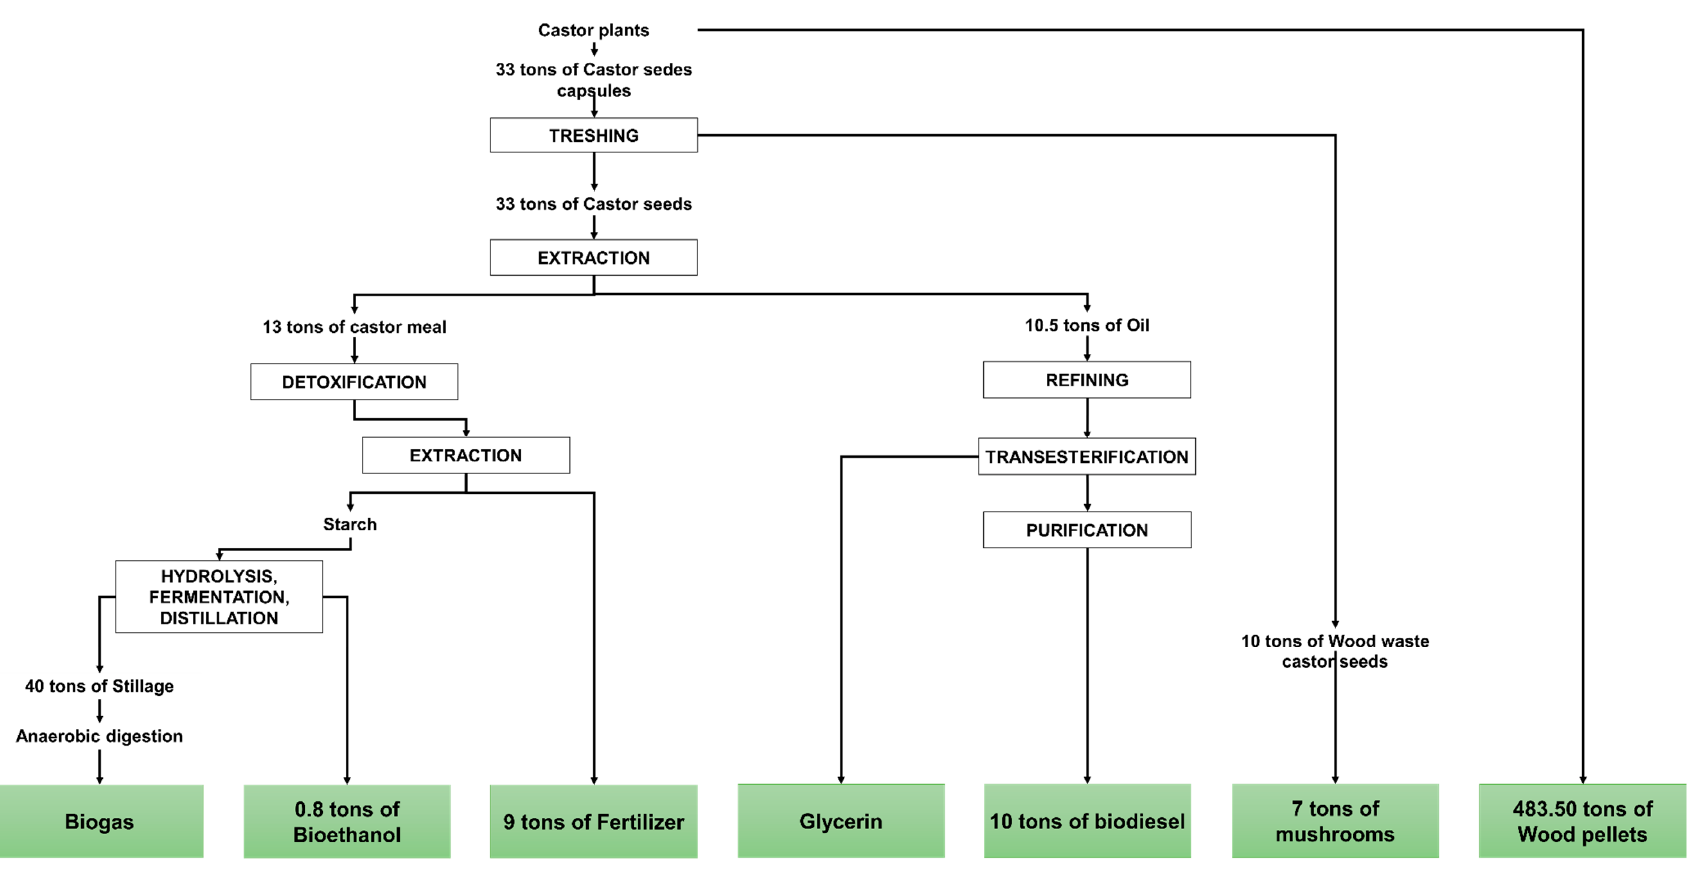
Figure 5. General balance of matter of processes developed in the project.